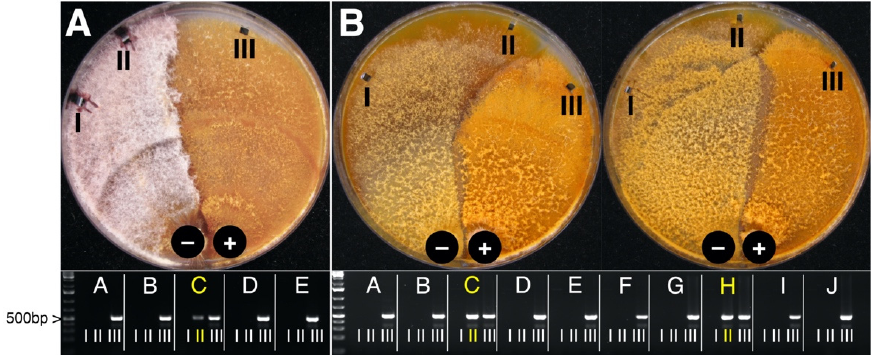
Figure 6. Pairwise co-cultivation of CnFGV1-positive (+) Cryphonectria naterciae and CnFGV1-free ( − ) Cryphonectria spp. ( A ) Donor strain in co-culture with replicate M2270-C of C. radicalis . ( B ) Donor strain in co-culture with replicate M9290-C and M9290-H of C. carpinicola . Agarose gels below show Cn-Vir-ORF1 fragments of five (A–E) or 10 (A–J) replicates to verify the virus transmission. The position III is from the donor side and always CnFGV1-positive. Yellow letters highlight the positive CnFGV1-transmission to the recipient.